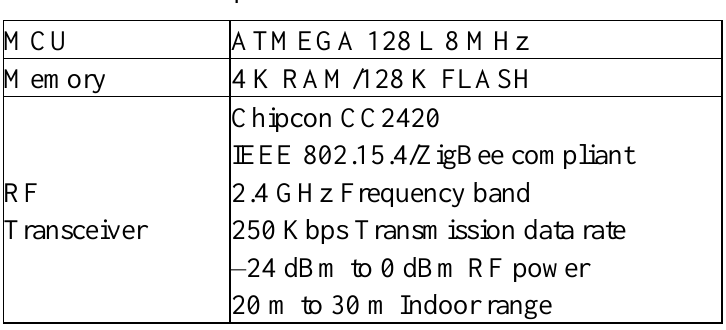
Table 2 . Specifications of simulated